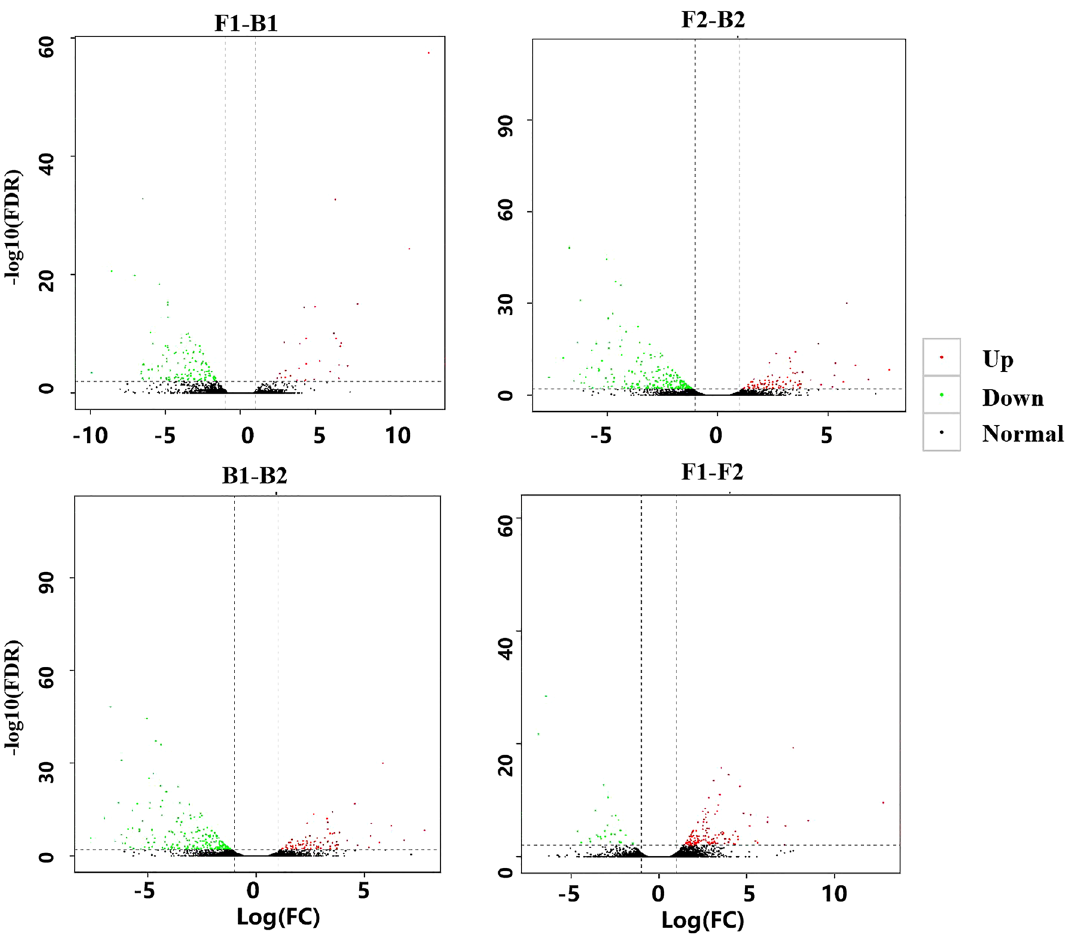
Figure 3. Analysis of the volcano map of different genes in various parts of the peanut testa at different developmental stages. The abscissa indicates the multiple of difference, and the ordinate indicates − log10 (q-value). Red dots indicate up-regulation of gene expression, green dots indicate down-regulation of gene expression, and black dots indicate that there is no significant difference in gene